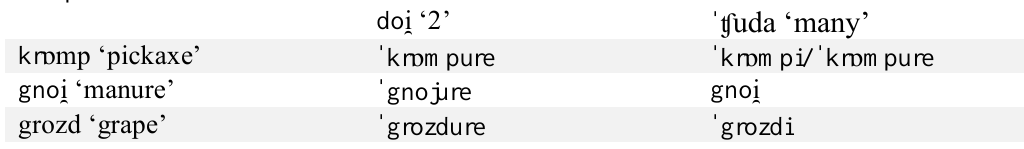
Table 2. Behaviour of nouns in numeral quantifier phrases vs phrases with indefinite ˈ ʧ uda in responses from ST